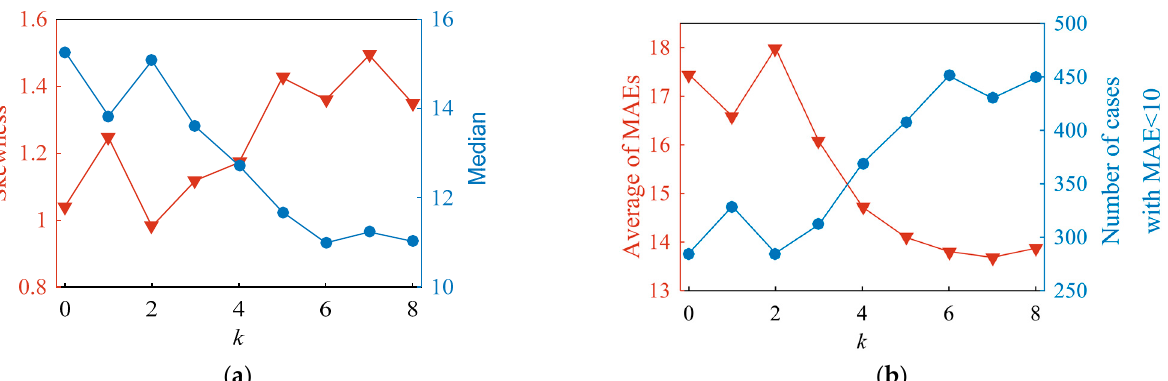
Figure 11. ( a ) Curves of estimated skewness and median; ( b ) Average MAE and the number of cases with MAE less than 10.